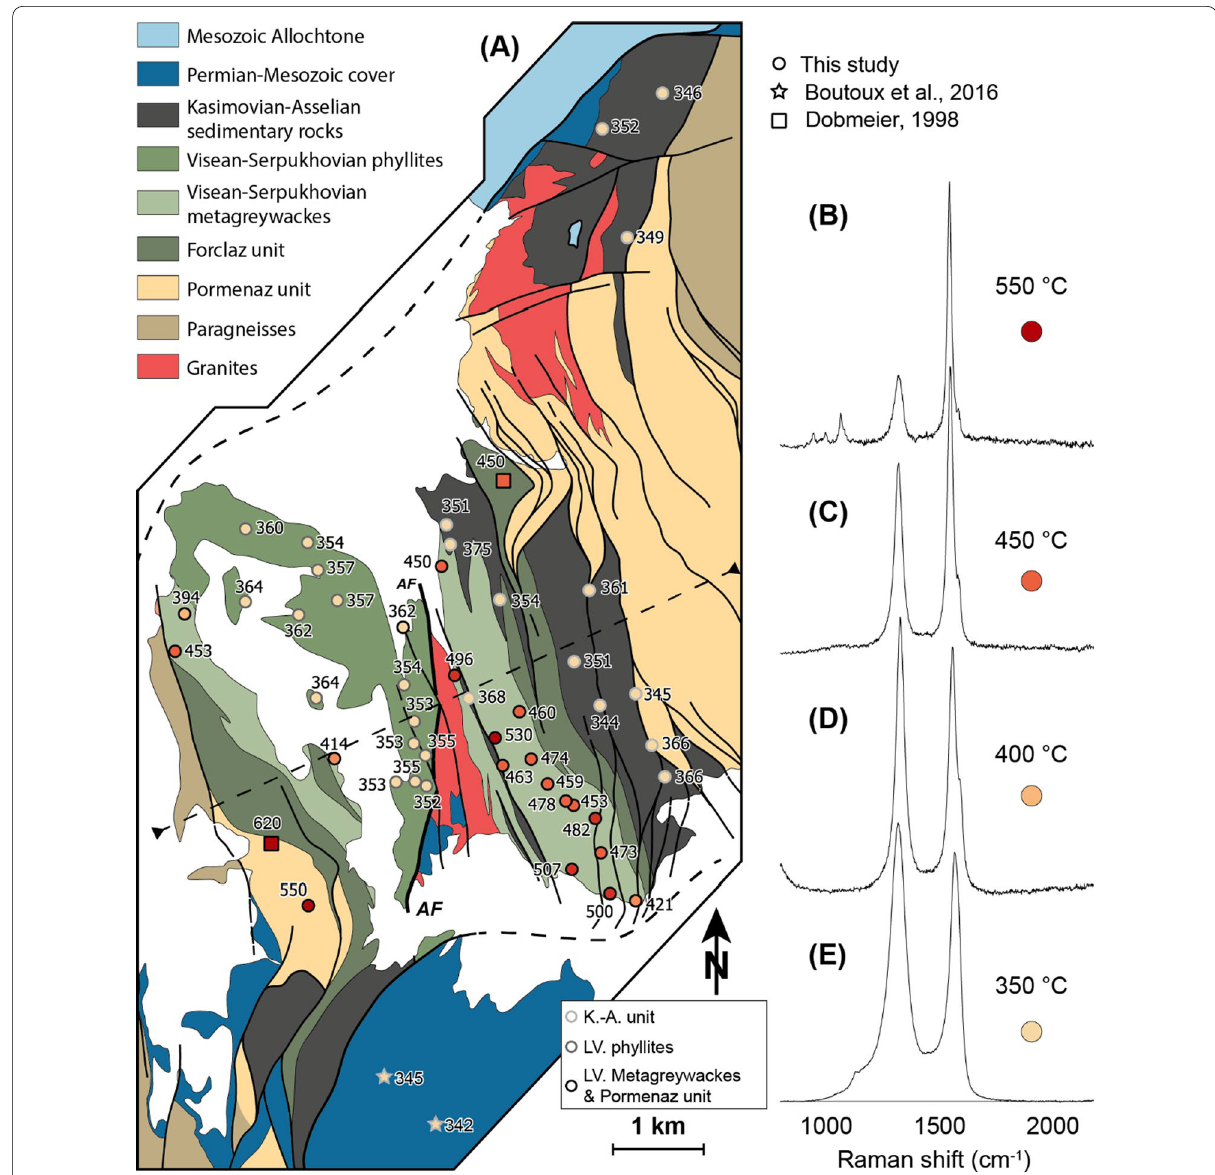
Fig. 6 A Map of the Servoz syncline with mean foliations and T RSCM temperatures, and B – E representative Raman spectra of carbonaceous material of four samples with varied temperatures. Colour of each sample is related to its T RSCM temperature. Cross‑section of Fig. 7A is located. AF: Arve